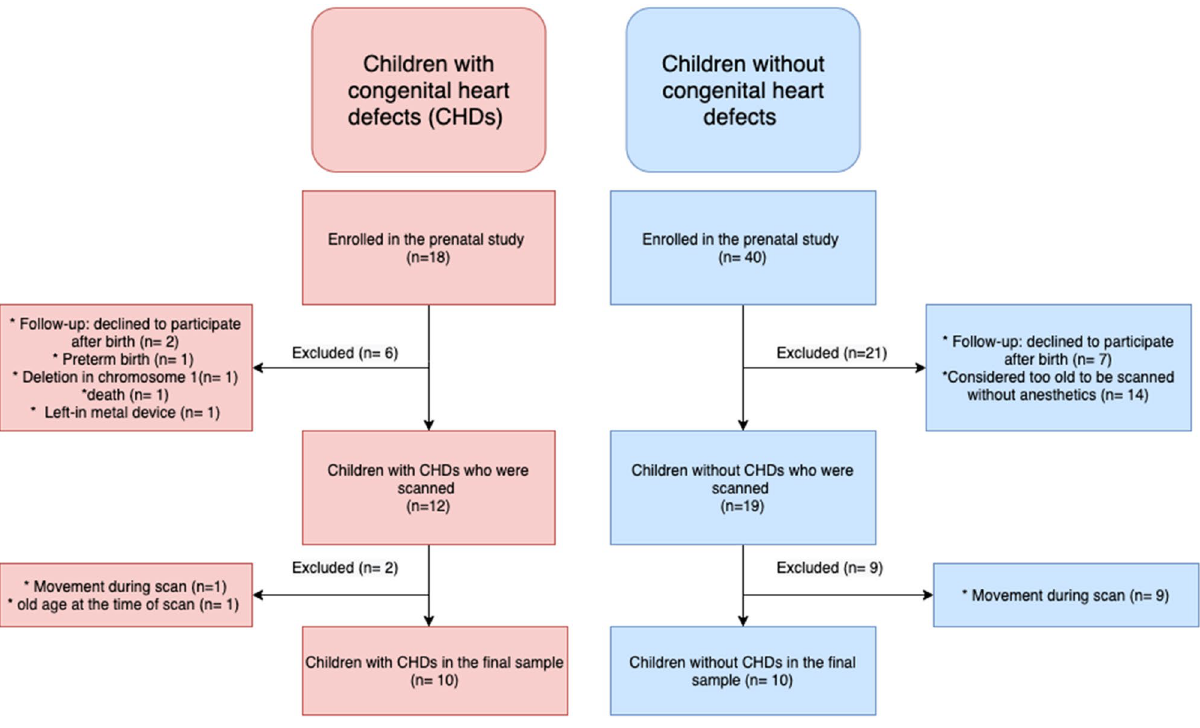
Figure 1. Flow-chart describing the enrollment